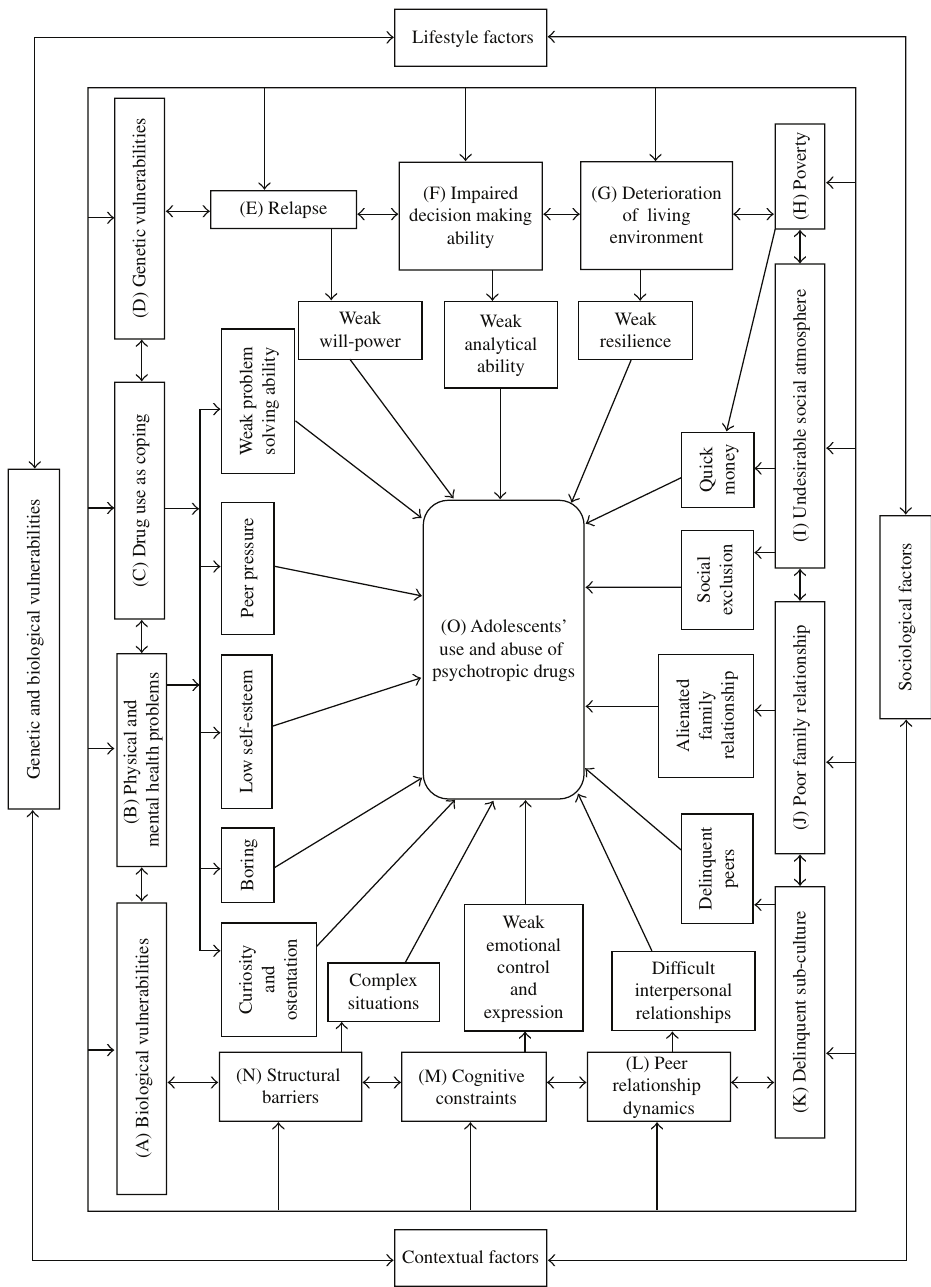
FIGURE 2: A revised model of causes of adolescents’ use and abuse of psychotropic drugs at the micro-